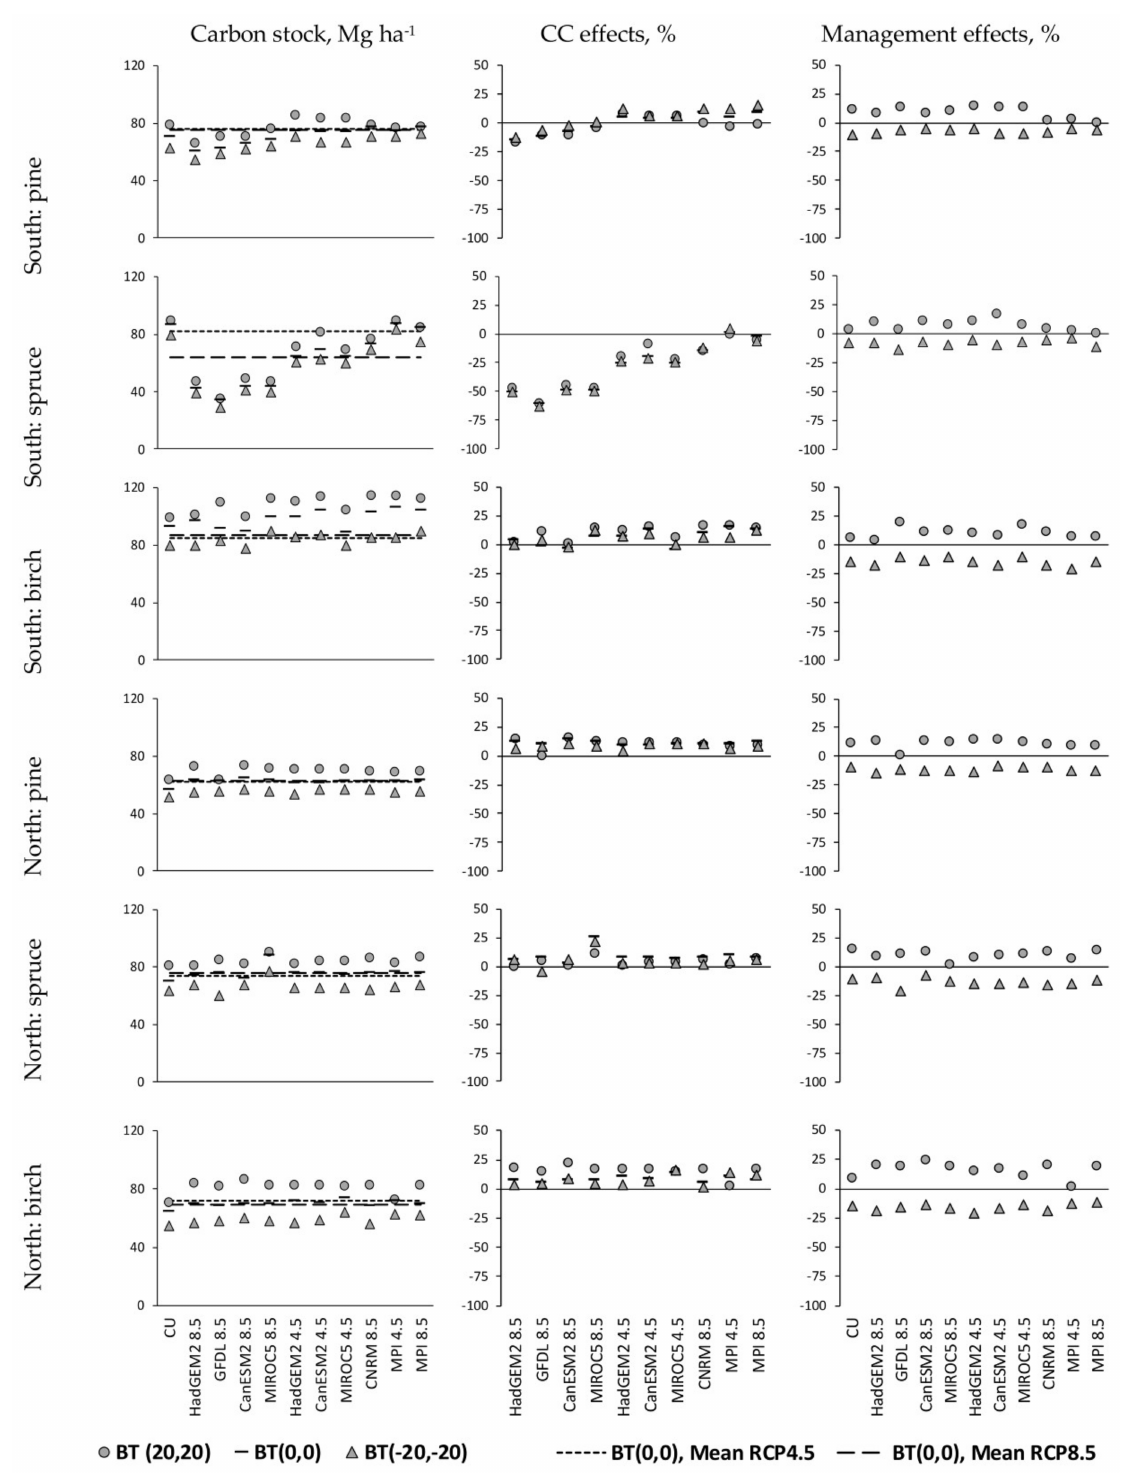
Figure 3. The total ecosystem carbon stock (in trees and soil, Mg ha − 1 ) in Scots pine, Norway spruce and Silver birch stands with different management regimes under the current climate (CU) and individual GCM projections (shown in table 2), under the RCP4.5 and RCP8.5 forcing scenarios, in southern and northern Finland. As a comparison, absolute values (on the left) for the multi-model means of the GCMs under the RCP4.5 (Mean RCP4.5) and RCP8.5 (Mean RCP8.5) forcing scenarios are